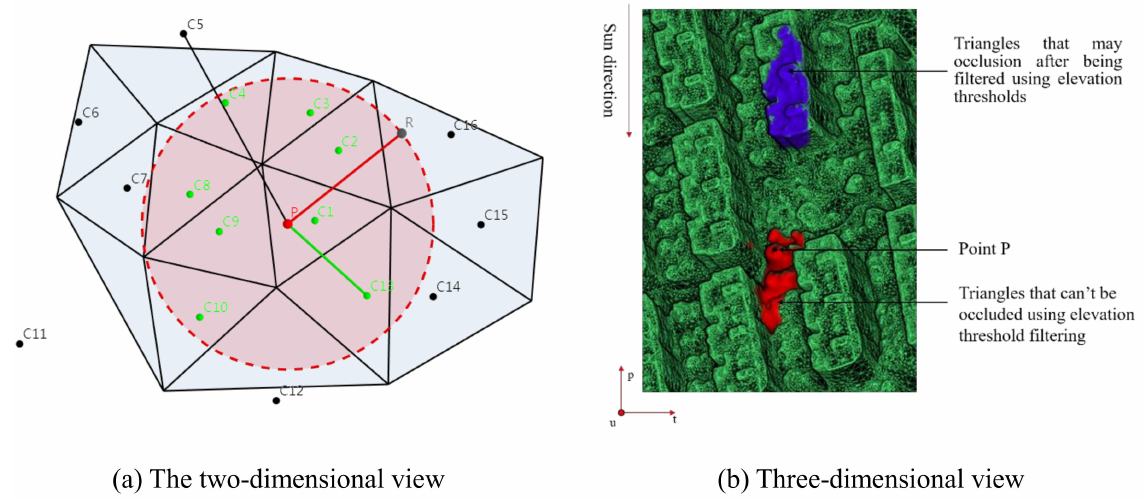
Figure 5. Illustration of occlusion